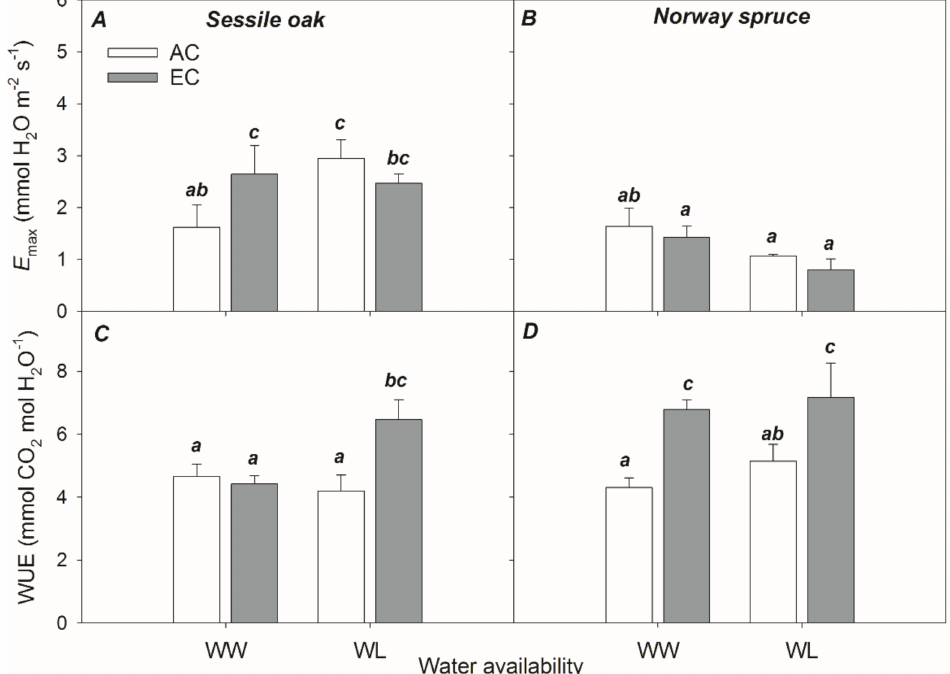
Figure 4. Effect of CO 2 concentration and water availability on transpiration rate ( E max ; ( A , B )) and water use efficiency (WUE; ( C , D )) at saturating light intensity in sessile oak (left) and Norway spruce (right) saplings. The measurements were made during the second growing season of cultivation under manipulated conditions: AC—ambient CO 2 concentration (~400 µ mol CO 2 mol –1 ), EC—elevated CO 2 concentration (~700 µ mol CO 2 mol –1 ), WW—well-watered (regular watering of 20 mm per week during vegetation period), WL—water-limited (no irrigation for 5 weeks before the measurements). Means (columns) and standard deviations (error bars) are presented ( n = 3). Different letters indicate significant differences ( p ≤ 0.05) between means based on Tukey’s ANOVA post-hoc